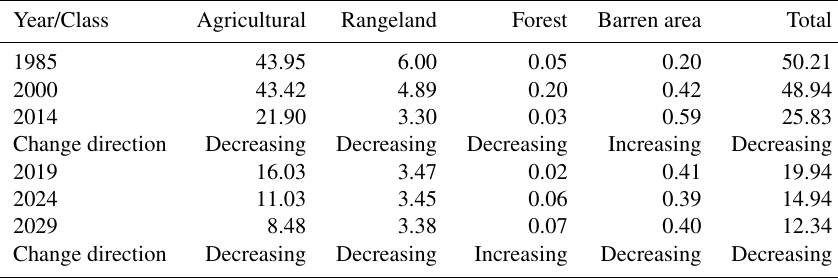
Table 9. Simulated carbon sequestration of the study area from 2014 to 2029 (millions of tons).